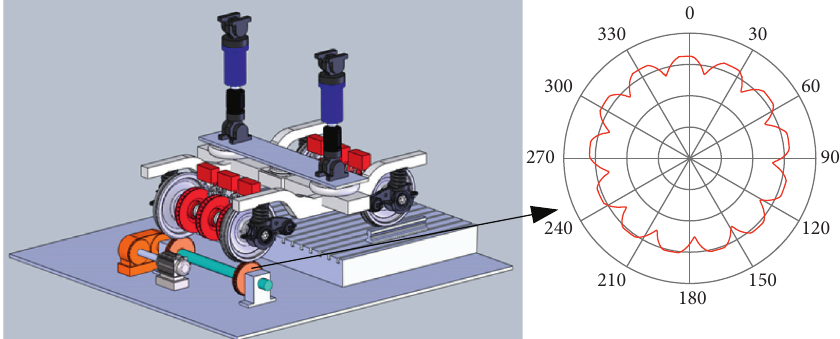
Figure 6: Schematic diagram of the test rig.